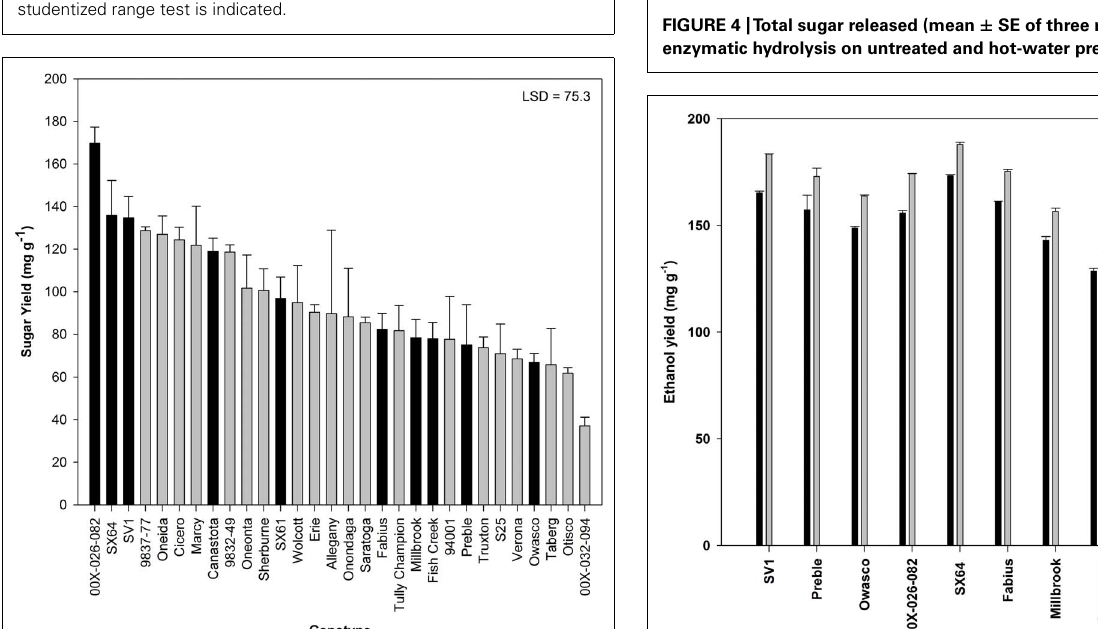
FIGURE 2 |Wood density (mean ± SE of three replicates) from 3 year growth at Constableville, NY, USA. Black bars indicate 10 genotypes selected for pretreatment. Least significant difference (LSD) fromTukey’s studentized range test is indicated.